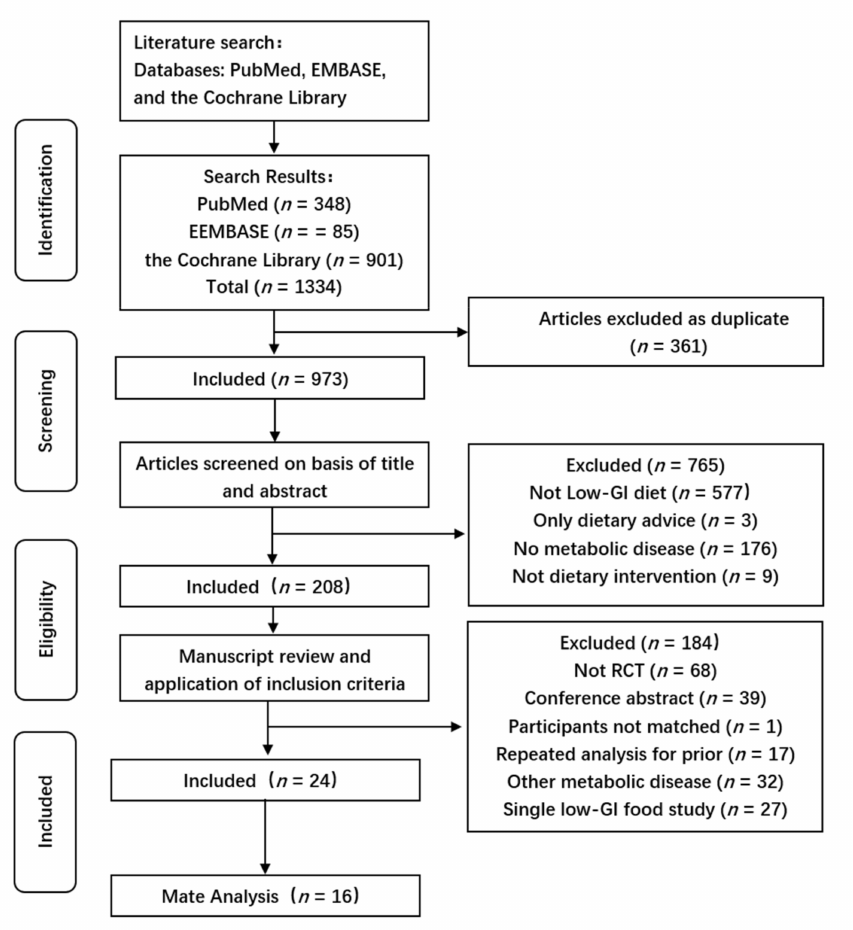
Figure 1. PRISMA flow diagram. Of an initial 1334 independent records, 361 were duplicates. A further 765 and 184 were excluded after scrutinization at the title/abstract and full-text levels, respectively, leaving 24 articles. Data from all 16 articles were included in the